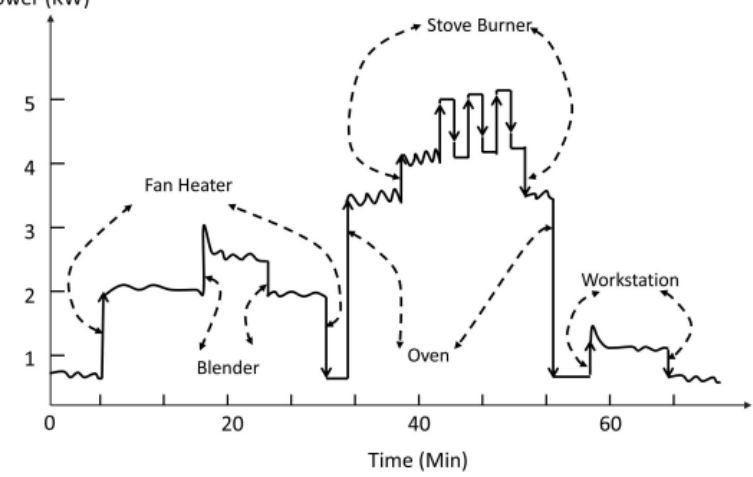
Figure 1. The first concept of NILM based on a single point measurement by Hart